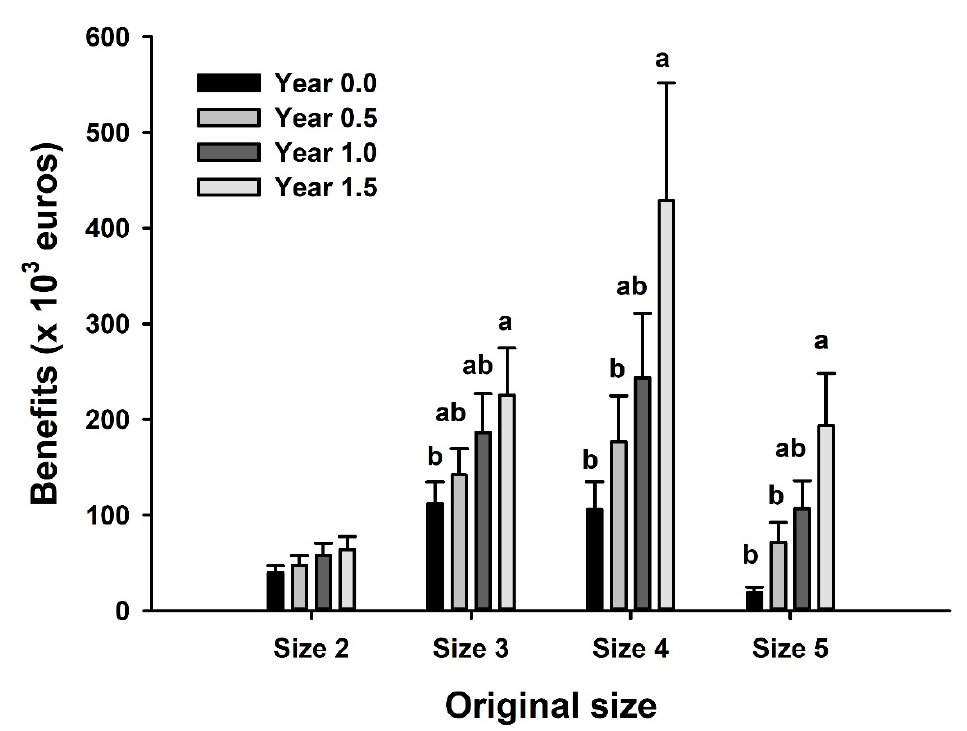
Figure 4. Averaged sale price in the fish market of rubberlip grunt caught in Conil since 2016 (until May 2022) depending on the commercial size (year 0.0). The figure shows the price that these same individuals would have reached if they had been released and further recaptured after 0.5, 1.0 and 1.5 years. Columns show mean + SEM ( n = 7 years). Different letters indicate significant differences among groups of the same commercial size ( p < 0.05, one-way ANOVA followed by a Tukey post hoc test).